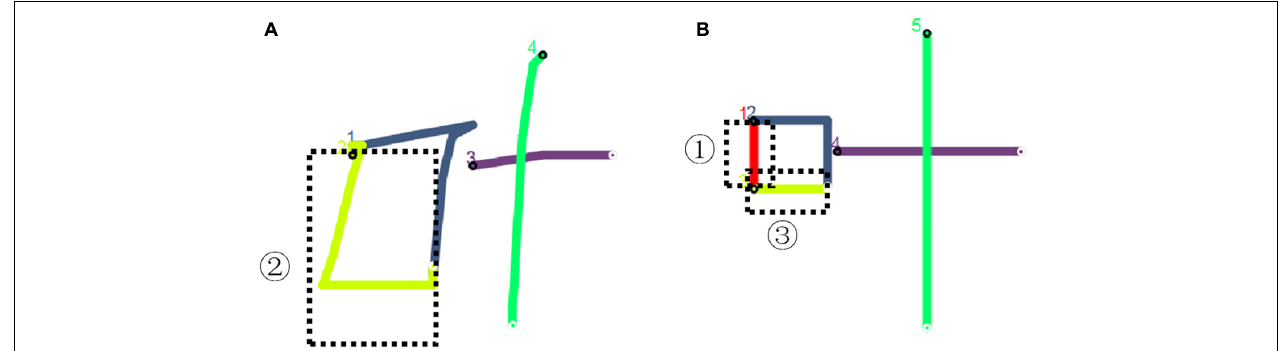
FIGURE 3 | (A, B) The visualization of “ ” written by a writer and the standard form.